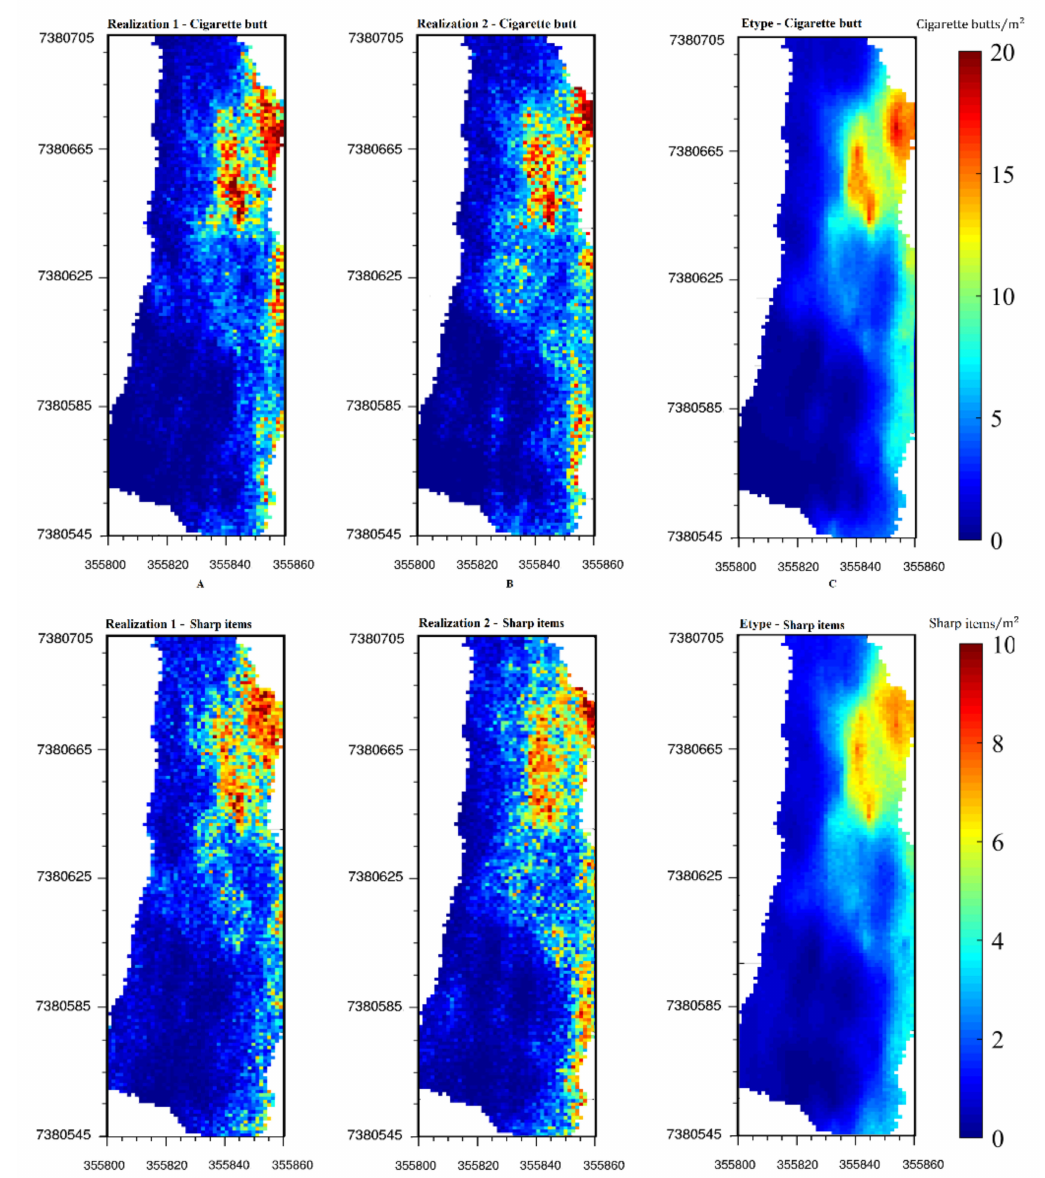
Figure 8. Two generated realizations of ( A , B ) cigarettes butt, ( D , E ) sharp items. Average of one hundred realizations for ( C ) cigarette butts and ( F ) sharp